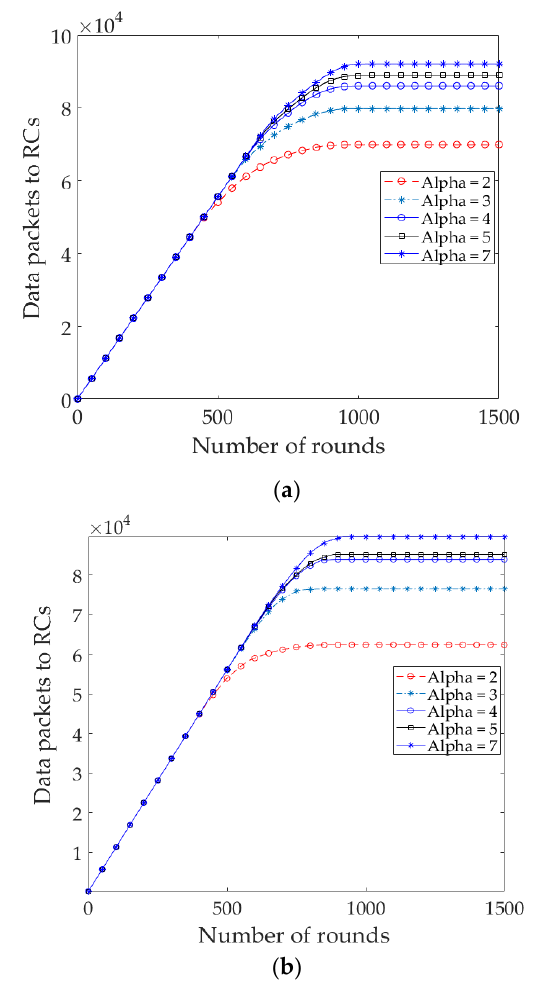
Figure 9. ( a ) Number of local data packets sent to RC nodes for different T E in EDR (uniform); ( b ) Number of local data packets sent to RC nodes for different T E in EDR (nonuniform).